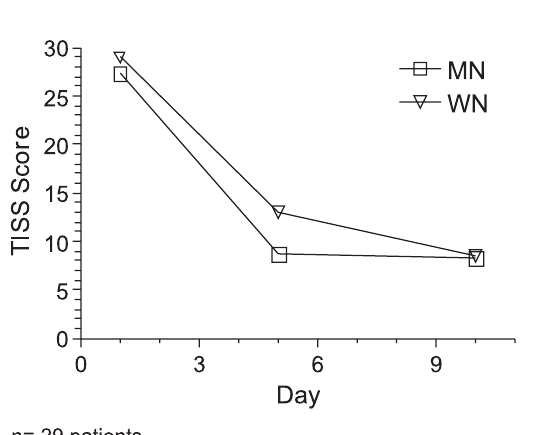
Figure 1 - Therapeutic Intervention Scoring System (TISS) evolution in Mn and Wn patients during the period of study